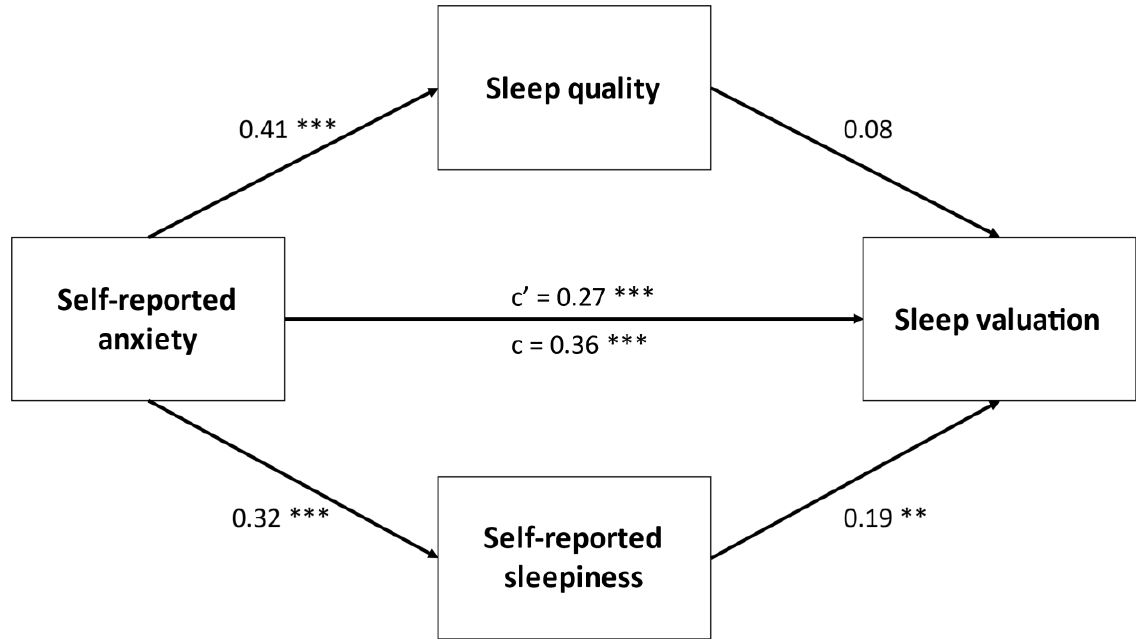
Figure 4. Parallel mediation between self-reported anxiety and sleep valuation. Values are standardized β . ** p < 0.01, *** p < 0.001.